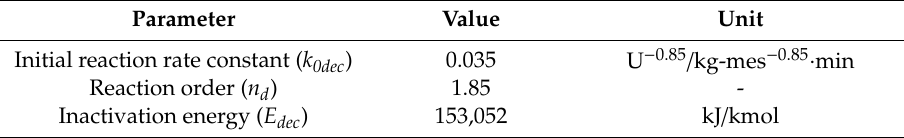
Table 4. Estimated parameters for the kinetic of thermal inactivation of lipase.